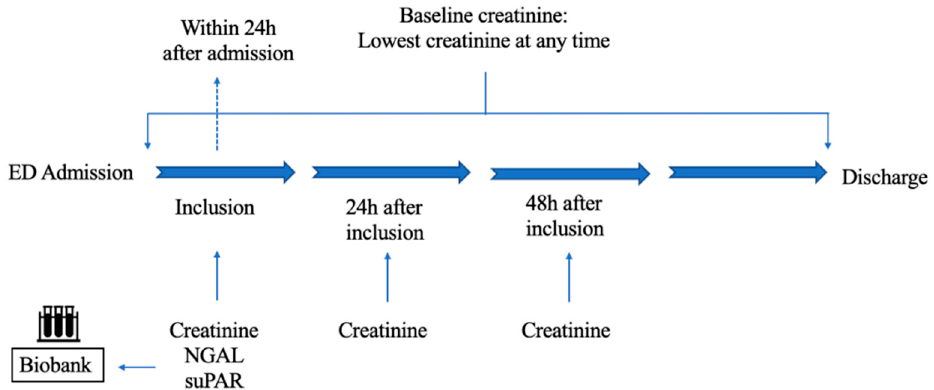
Figure A4. Flow diagram illustrating biomarker measurements during hospitalization. Creatinine was measured repeatedly during hospitalization, including admission, inclusion day (day 0), 24 h (day 1) and 48 h (day 2) after inclusion. Plasma neutrophil gelatinase-associated lipocalin (NGAL) and soluble urokinase plasminogen activator receptor (suPAR) were measured at inclusion, in addition to creatinine measured at inclusion, these markers were obtained from the samples stored in the Biobank. Patients were included within 24 h after admission. ED, emergency depart- ment.